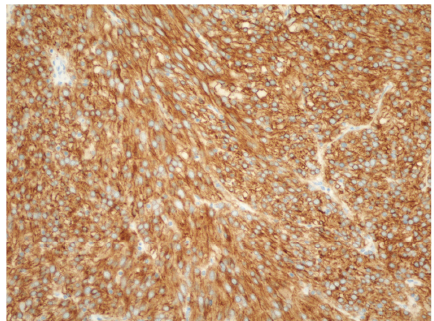
Figure 4: Microscopic finding: immunohistochemistry exhibiting a strong positive for CD117 (CD117 stain;